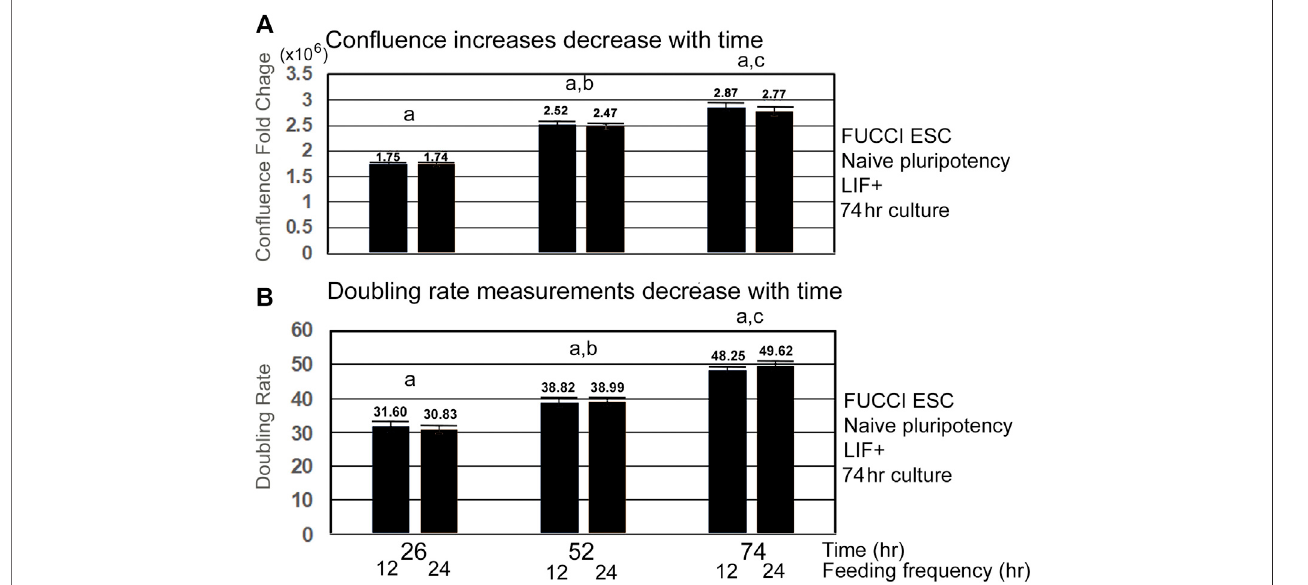
FIGURE 3 | Velocity of increase in con fl uence decreases with time, and doubling rates get slower with time as con fl uence and contact inhibition increases. FUCCI ESCsentertheS-G2-MphaseaftermediumchangeduringNSculturewithLIF.FUCCIESCswerepassedinto96-wellplatesandhad fi rstmediumchangeofNS/LLIF+ mediaatTzero,werefedat24and48hor12,24,36,48,and60 h,andthenassayedforcon fl uenceinanIncuCyteZoomliveimager. (A) showsthefoldchangewhereas (B) shows the doubling rate of con fl uence from the stated time to 2 h. (a) There is no signi fi cant difference in fold change or doubling rate for the different feeding schedules. (b) At 52 h, FC and doubling rates are signi fi cantly slower than those for 26 h ( p < 0.005). (c) Time 74 FC and doubling rates are signi fi cantly different than those for Time 52 ( p < 0.05 for FC, p < 0.0001 for doubling rates). Five independent biological experiments from 12-h feeding frequency and six independent biological experiments for 24-h feeding frequency with paired replicate wells in each experiment for each dose and stimulus were used for statistical analysis. SameN as shown in Figure 1 . Con fl uence at T68 was used instead of T74 for datasets without T74.